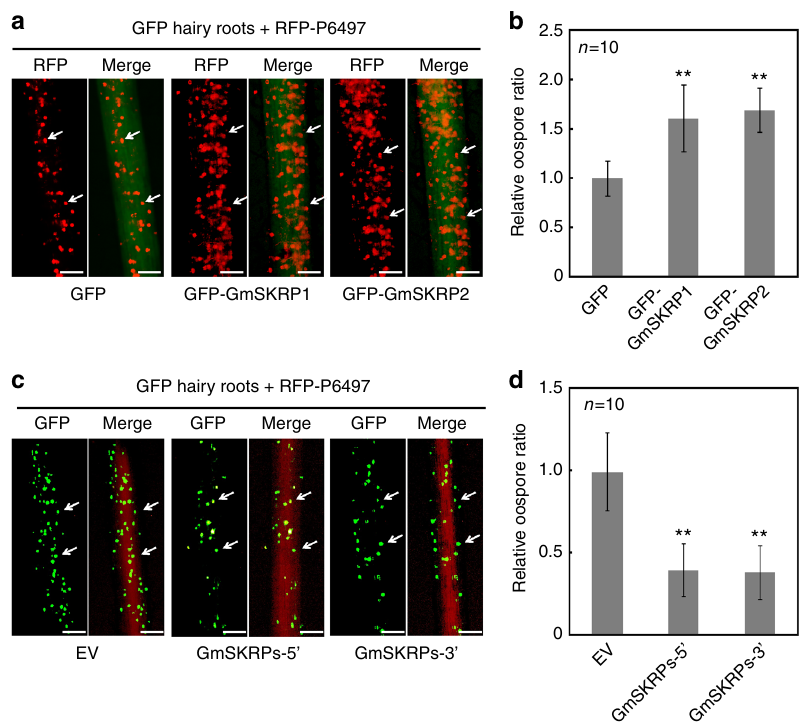
Fig. 4 GmSKRP1/2 are negative regulators of plant immunity. a Overexpression of GFP-GmSKRP1/2 in hairy roots ( rps3c ) promotes P . sojae infection. Transformed hairy roots were selected based on the green fl uorescence. The fl uorescent hairy roots were inoculated with RFP-labeled P6497 strain of P . sojae . Images of infected hairy roots were photographed at 48 hpi. The oospores were indicated with arrows. Three independent experiments showed similar results. Scale bars represent 0.25 mm. b Statistic analysis of ( a ). Oospore numbers on inoculated hairy roots were measured. Means and standard errors from ten replicates are shown (** P < 0.01; one-way ANOVA). Experiments were repeated three times with similar results. c Silencing of GFP-GmSKRP1/2 in soybean hairy roots ( rps3c ) enhances soybean resistance. Transformed hairy roots were selected based on the red fl uorescence. Silenced hairy roots with RFP marker were inoculated with GFP-labeled P6497 strain of P . sojae . GmSKRP1/2 genes were simultaneously silenced by either 5 ′ -end silencing fragment (GmSKRP-5 ′ ) or 3 ′ end silencing fragment (GmSKRP-3 ′ ). EV represents empty silencing vector. Infection images were taken at 48 hpi. The oospores were indicated with arrows. Three independent experiments showed similar results. Scale bars represent 0.25 mm. d Statistics of ( c ). Oospore numbers were measured in GmSKRPs silencing hairy roots (RFP-GmSKRP-5 ′ or RFP-GmSKRP-3 ′ ) and empty vector (EV) transformed hairy roots. Means and standard errors from ten replicates are shown (** P < 0.01; one-way ANOVA). Experiments were repeated